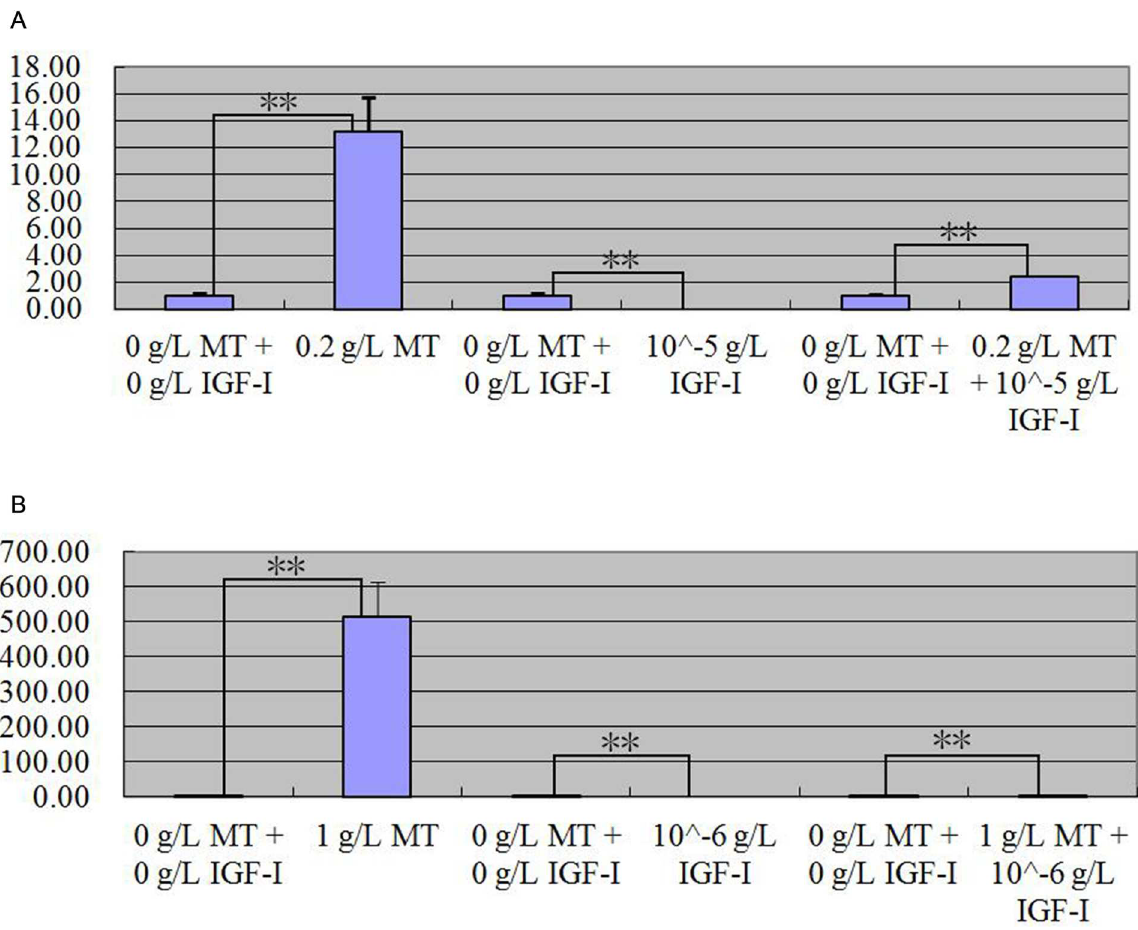
Fig 12. Expression quantity change of keratin 26 after 0.2 g/L MT and 10 − 5 g/L IGF-I treatment together for 24 h or 1 g/L MT and 10 − 6 g/L IGF-I treatment together for 72h was detected by quantitative real-time PCR. Fig 12A. Expression quantity of keratin 26 was 13.21 × (p < 0.01) greater in the groups which cells were treated with 0.2 g/L MT than the group which cells were treated with 0 g/L MT for 24 h, 0.0000083 × (p < 0.01) less in the groupswhich cells were treated with 10 − 5 g/L IGF-I than the group which cells were treated for 0 g/L IGF-I for 24 h, 2.41 × (p < 0.01) greater in the group which cells were treated with 0.2 g/L MT and 10 − 5 g/L IGF-I together than the group which cells were treated with 0 g/L IGF-I and 0 g/L MT for 24 h. Fig 12B. Expression quantity of keratin 26 was 513.36 × (p < 0.01) greater in the groups which cells were treated with 1 g/L MT than the group which cells were treated with 0 g/L MT for 72 h, 0.00009369 × (p < 0.01) less in the groupswhich cells were treated with 10 − 6 g/L IGF-I than the group which cells were treated for 0 g/L IGF-I for 72 h, 3.92 × (p < 0.01) greater in the group which cells were treated with 1 g/L MT and 10 − 6 g/L IGF-I togetherthan the group which cells were treated with 0 g/L IGF-I and 0 g/L MT for 72 h.